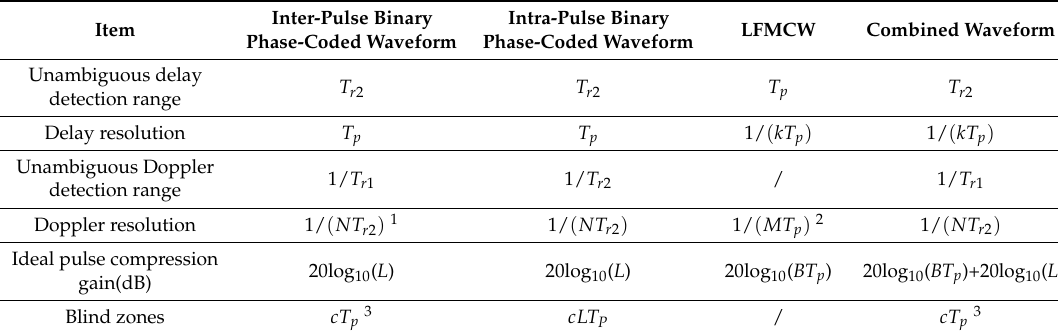
Table 1. Waveform characteristic